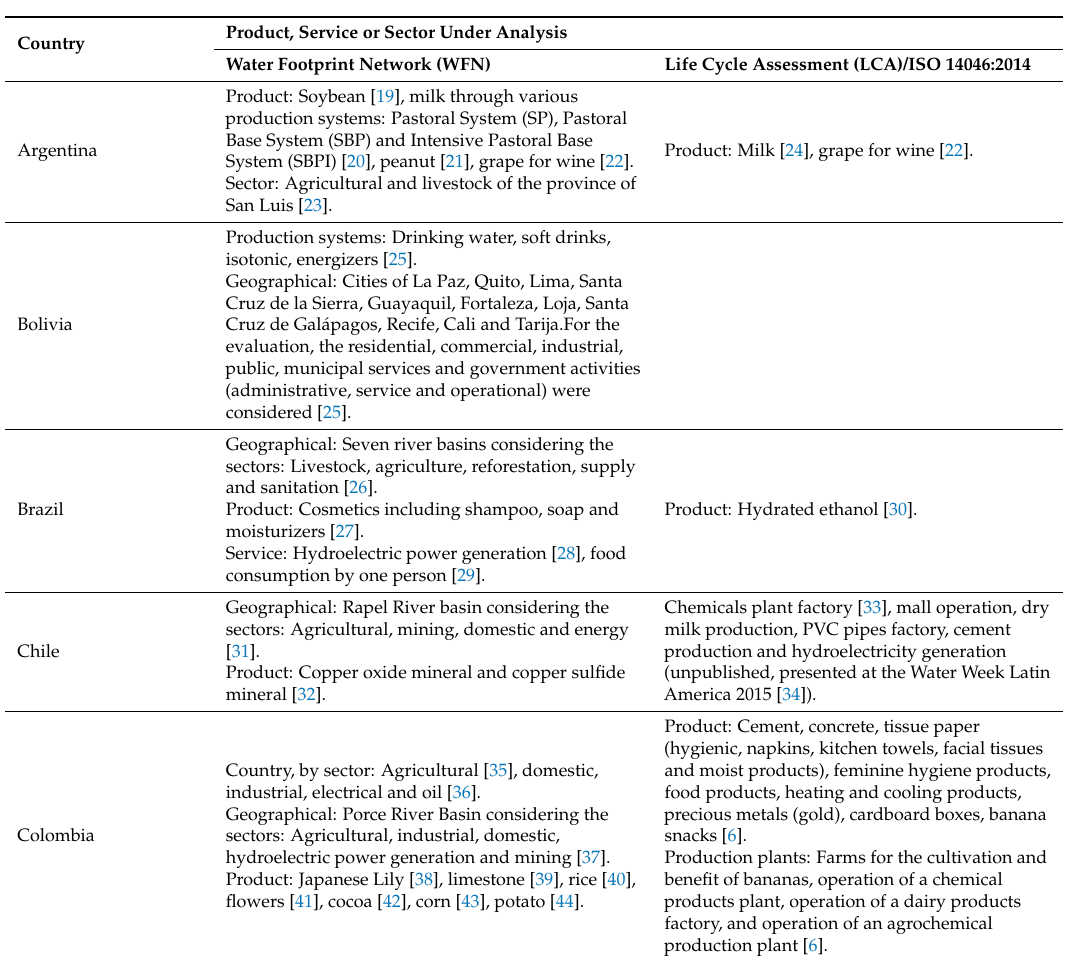
Table 2. State of the art in the quantification of the water footprint and the water footprint in Latin America. Modified from CADIS-COSUDE (2016)